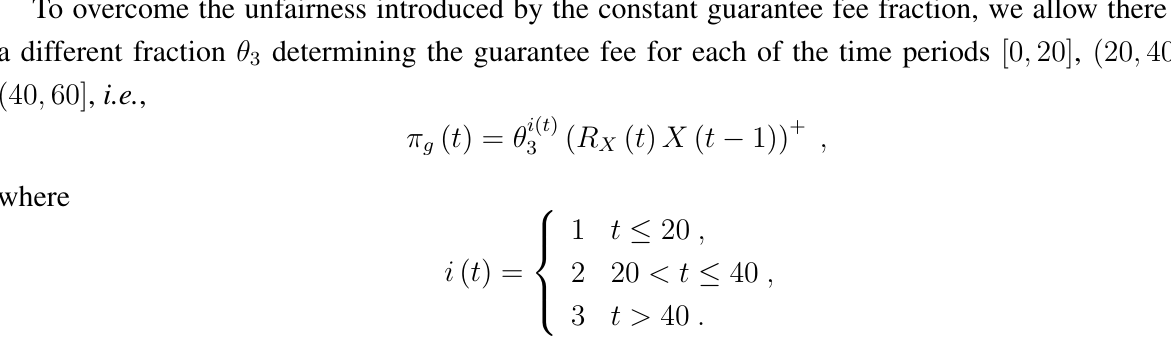
and k as function of 1 2